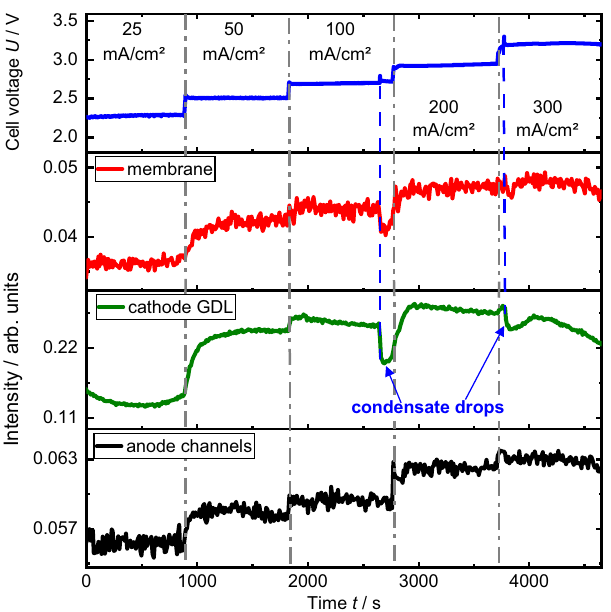
Fig.4|Temporalevolutionoftheneutronimagingexperiment. Cellvoltageand averaged intensities of membrane, cathode gas diffusion layer (GDL) and anode channelsareaovertime.The change inintensityvalues correspondsto achangein waterorprecipitatecontent.SeeSupplementaryFig.4forselectedregions.Source data are provided as a Source Data fi le.